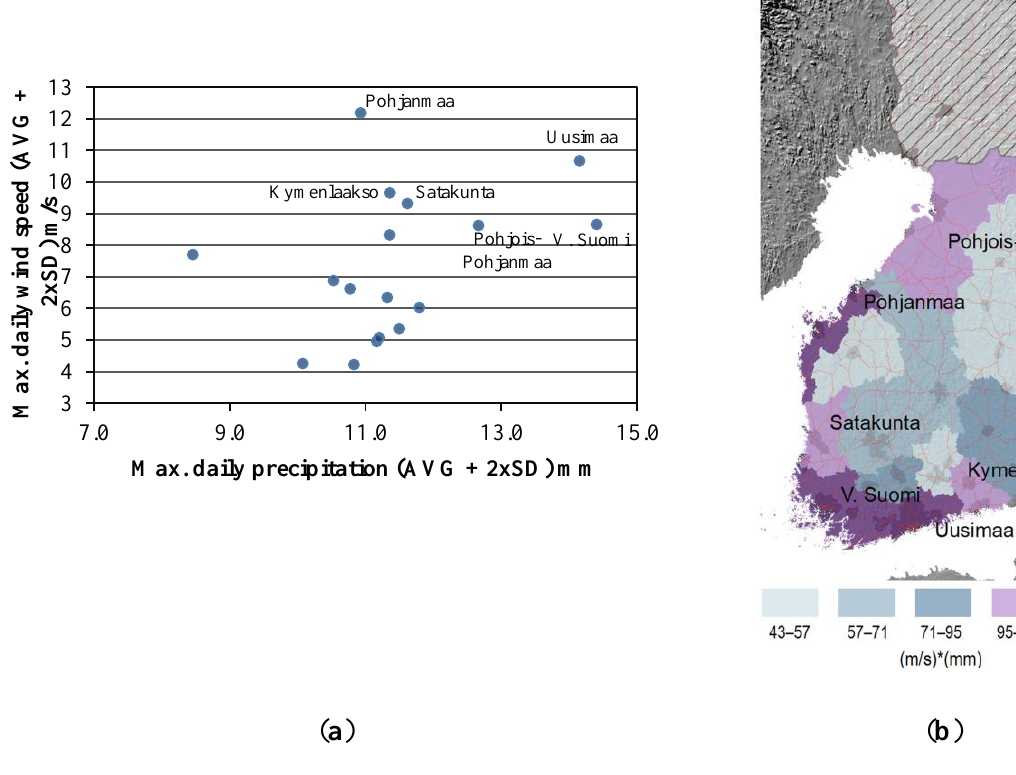
Figure 5. (a) Scatterplot of daily averages augmented by 2x standard deviation for precipitation and wind speed by region in winter periods based on observations from 2000 to 2010; and (b) Regional clustering (along the coast) of the highest observed combined wind speed and precipitation maximums (product of both